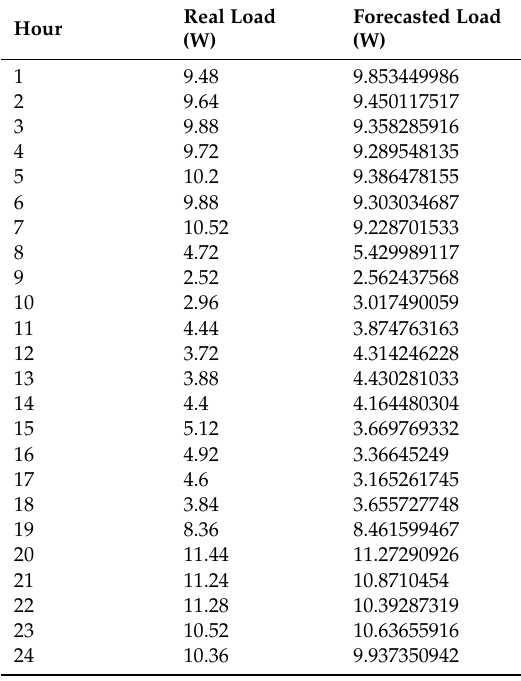
Table A3. Forecasting results and real data for load data for 04 / 02 / 2019.